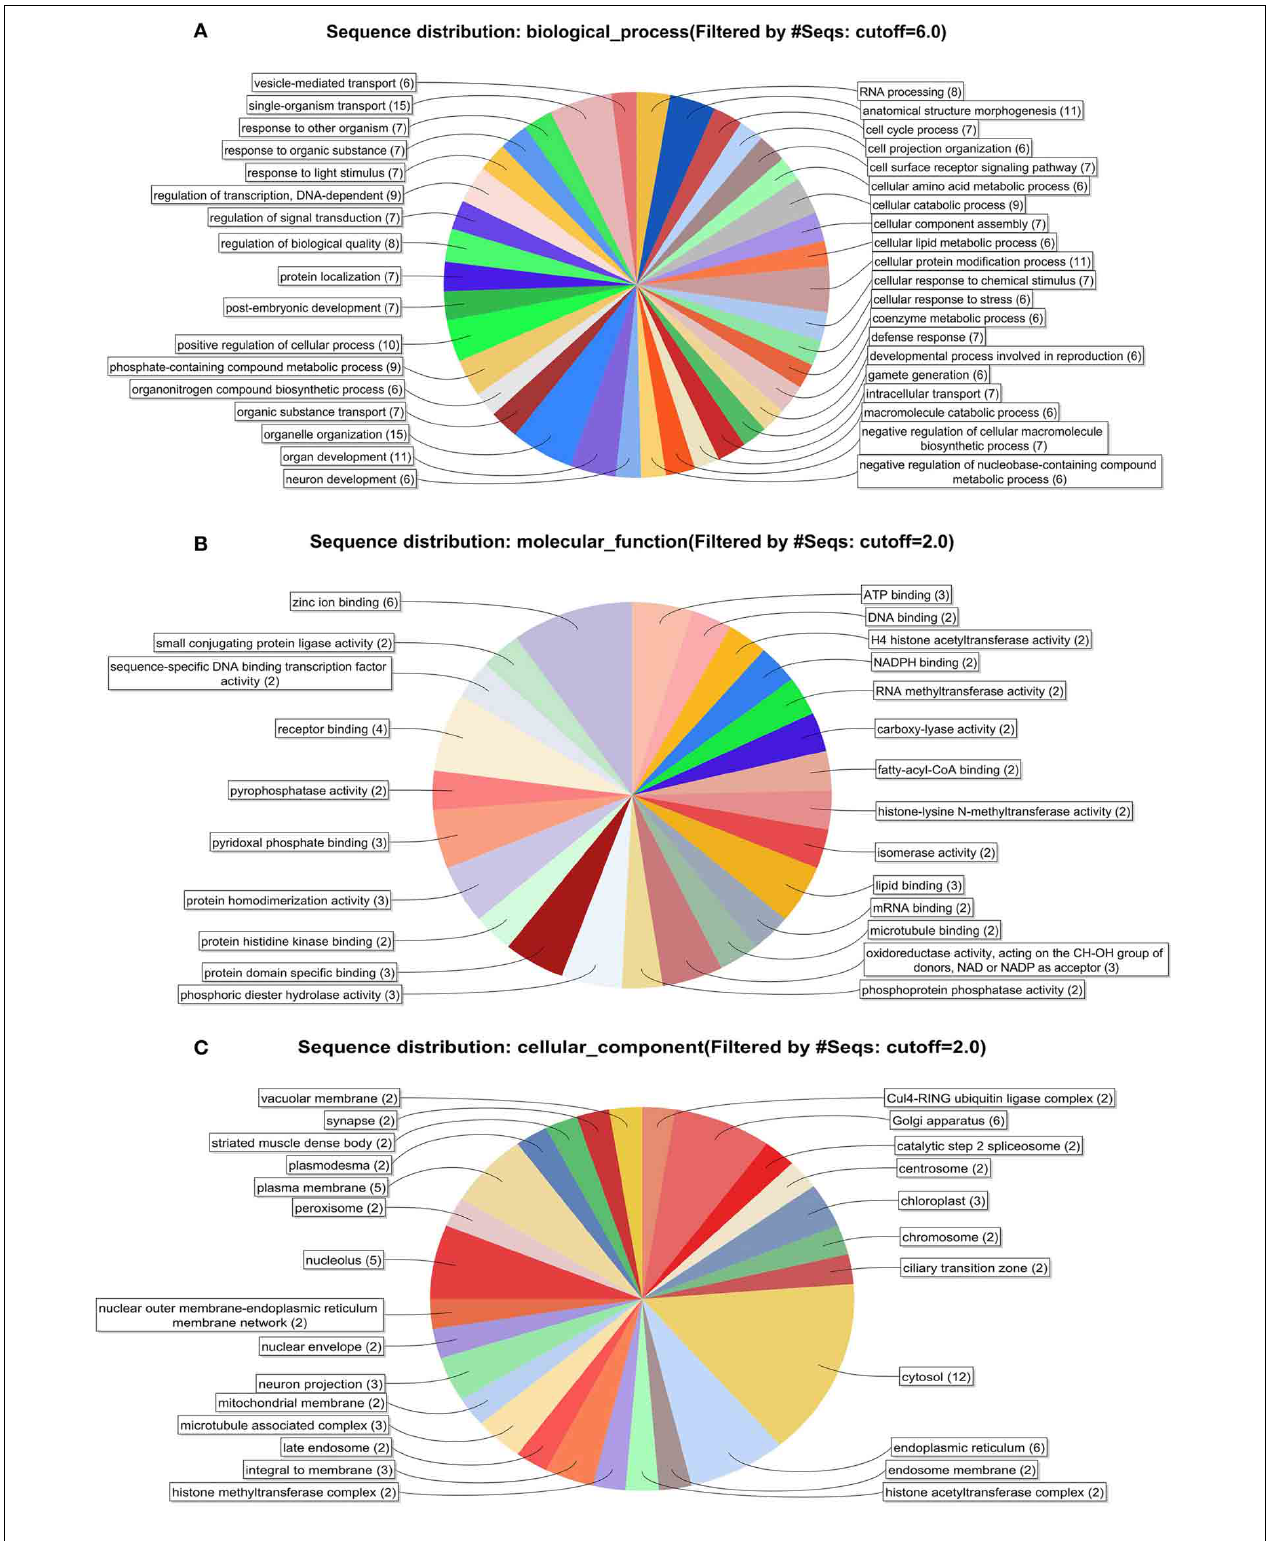
FIGURE 2 | (A) Distribution of biological process of the 105 sequences. (B) Distribution of molecular function of the 105 sequences. (C) Distribution of cellular component of the 105 sequences.